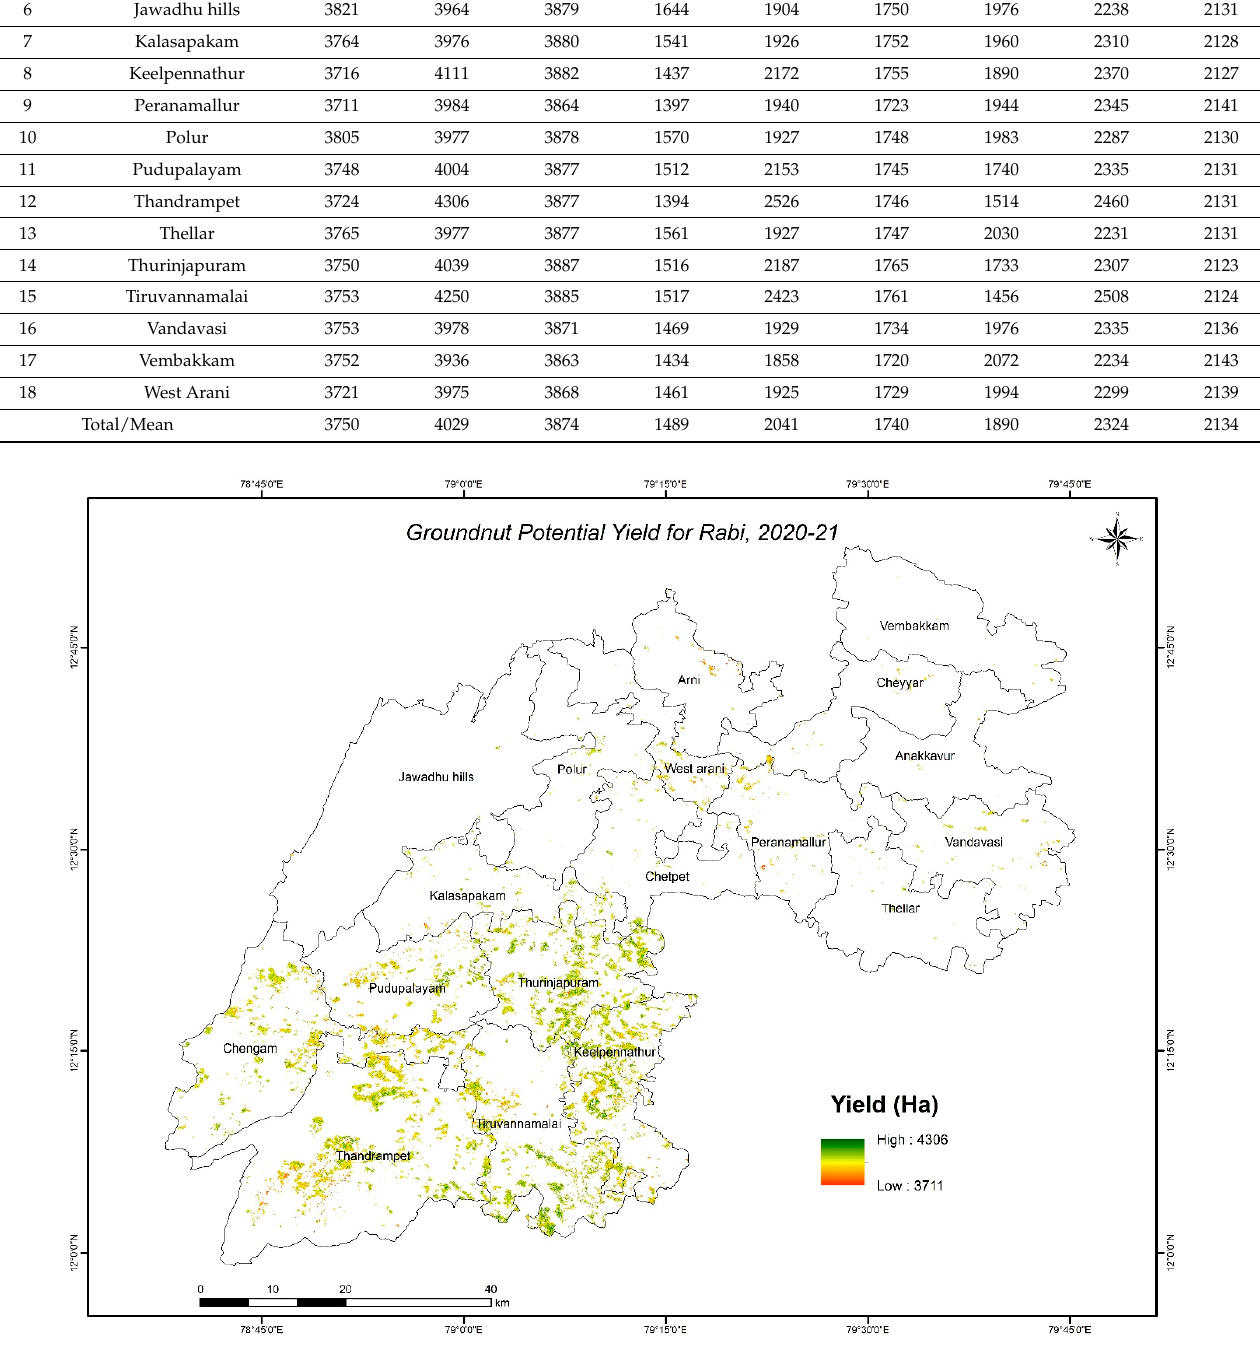
Figure 8. Peanut potential yield of Tiruvannamalai district during Rabi 2020–2021.